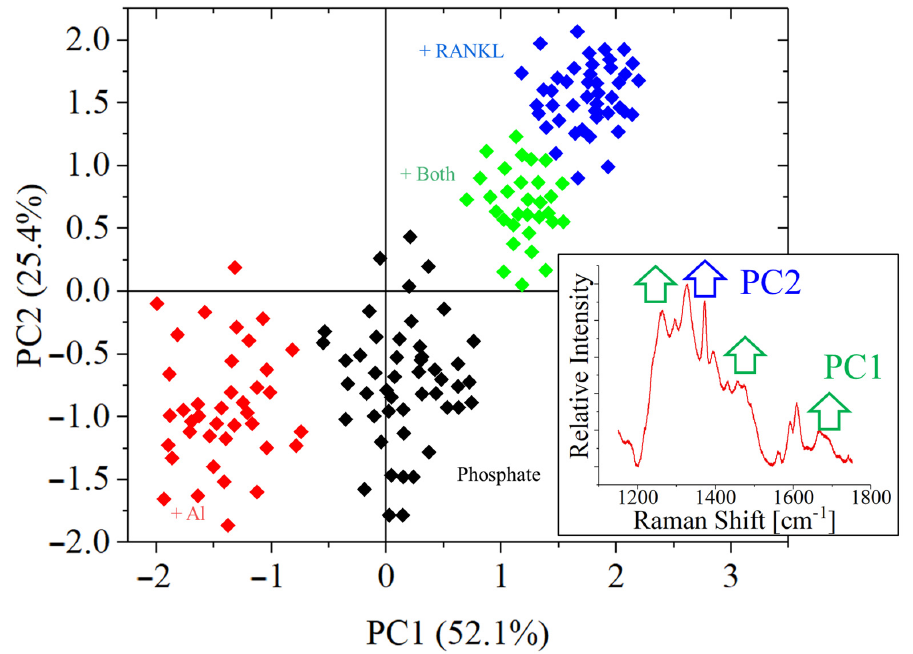
Figure 13. PCA analysis for the amide region of the octacalcium phosphate samples, PC1 related to the bandwidth of the 960 cm − 1 phosphate vibration and PC2 related to the intensity of the phenylalanine band at about 1004 cm − 1 .